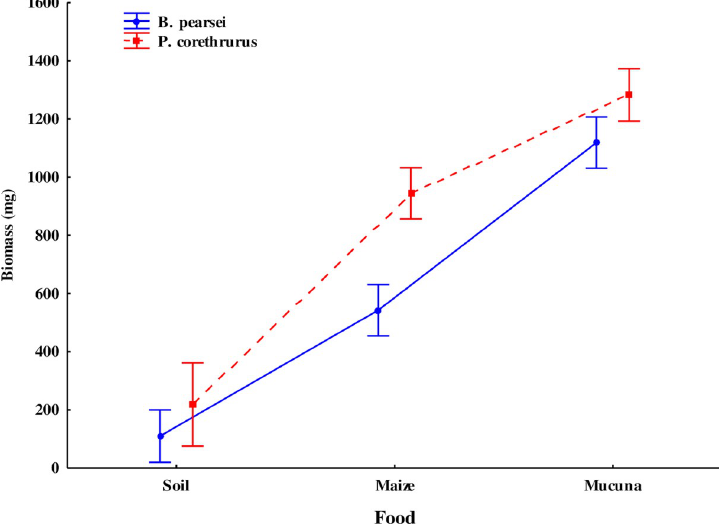
Fig 1. Biomass of the tropical endogeic earthworms Pontoscolex corethrurus (invasive) and Balanteodrilus pearsei (native) at 100 days of culture using three diets of different nutritional quality in soil with low anthropic impact. Vertical lines represent standard